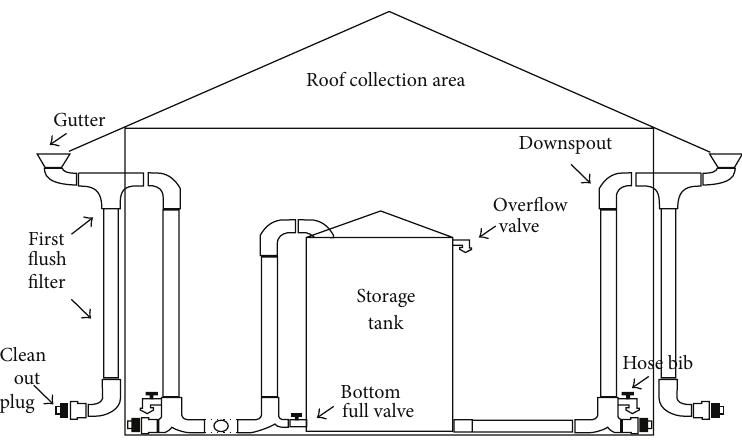
Figure 8: Schematic of a rainwater harvesting